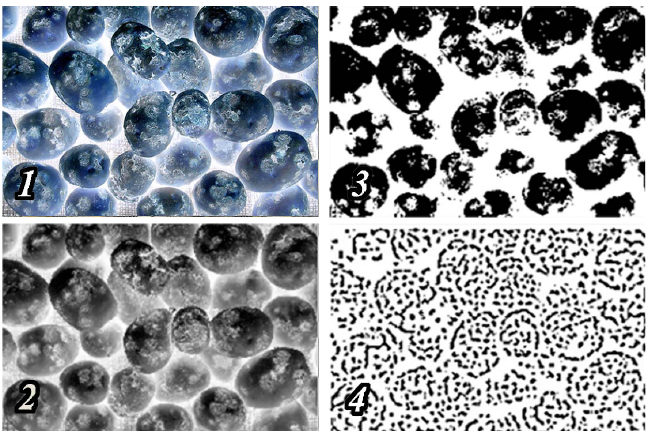
Figure 4. Inverted image and its processing ( 1 . Inverted image; 2 . Inverted image converted to grayscale; 3 . Threshold binarization applied (Otsu’s method); 4 . Adaptive binarization applied (Niblack’s method)).